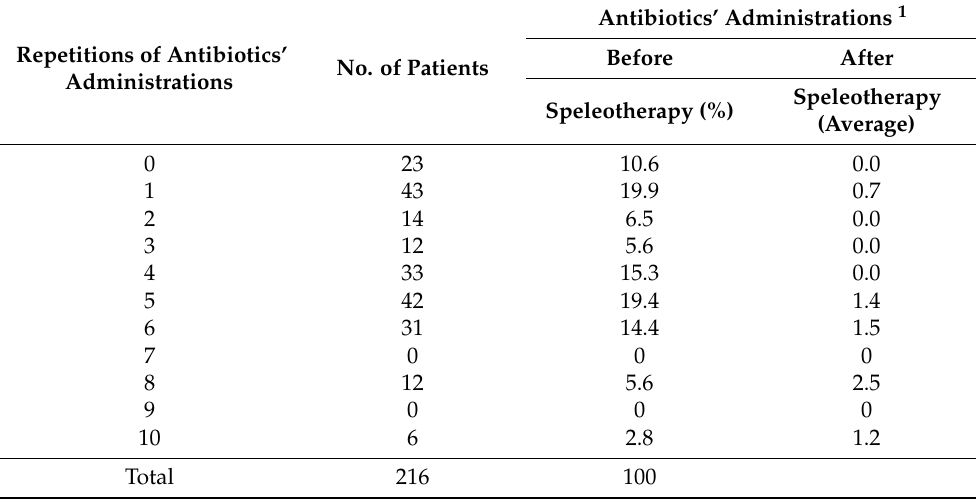
Table interpretation. 1 Antibiotics’ administration one year before and one year after the speleotherapy treatment in the Children’s Hospital with Speleotherapy in Ostrov u Macochy , Czech